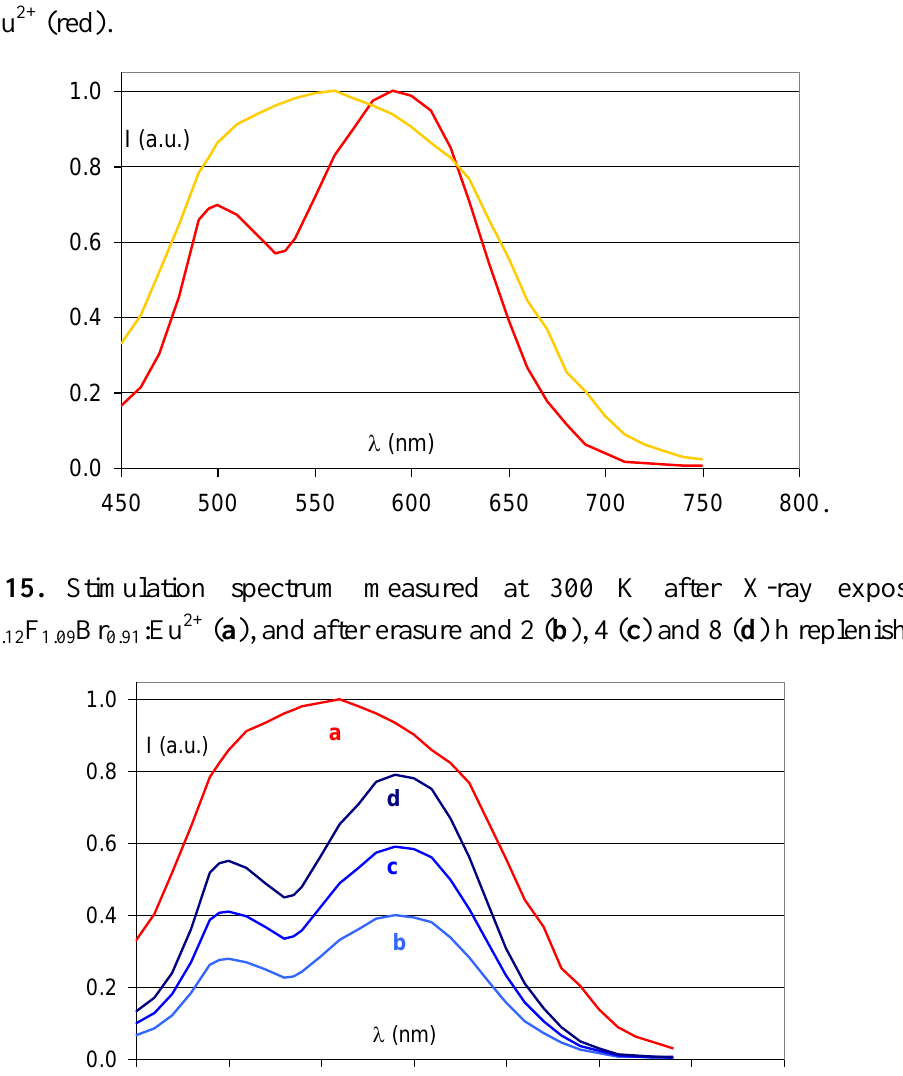
Sr FBr:Eu 2+ (gold) (data from [34]) and 0.82 0.18